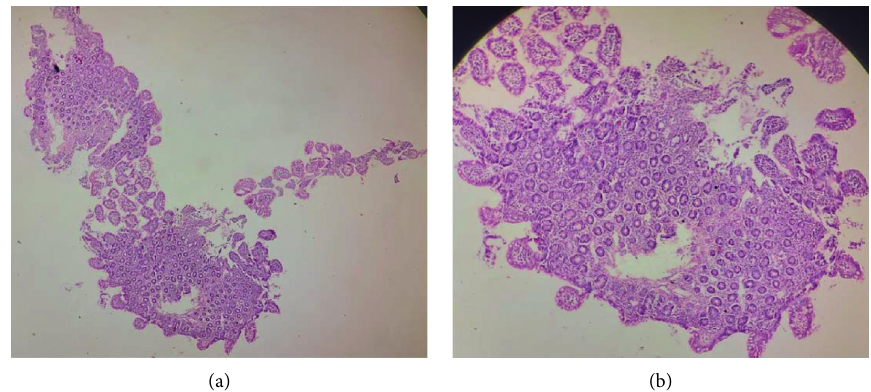
Figure 3: Hematoxylin-and-eosin-stained ileal biopsy showing mild focal loss and blunting of the villi.